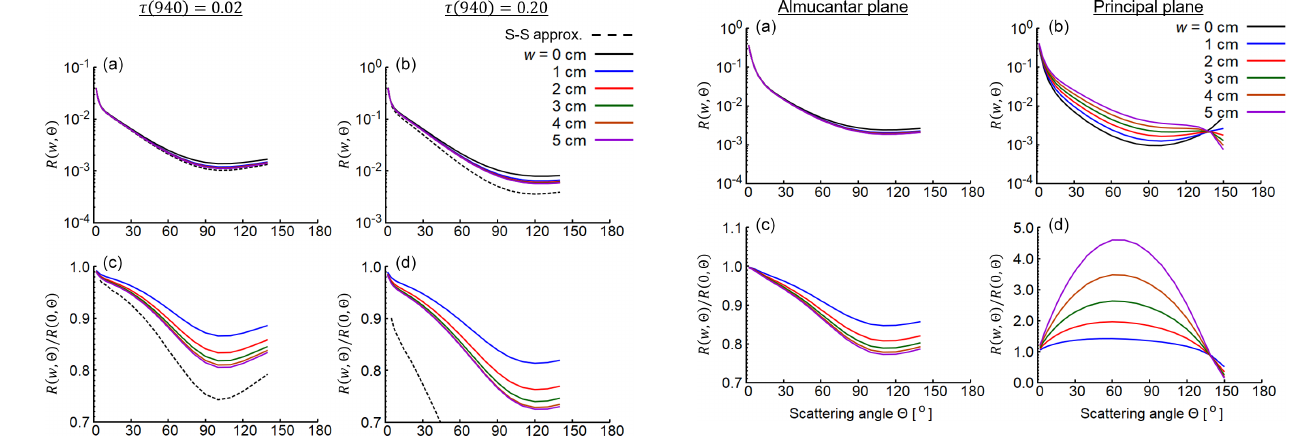
Figure 4. Normalized angular distributions simulated for transported-dust aerosol (Table 2) in the almucantar and prin- cipal planes with an aerosol optical thickness of 0.06 at 940nm. Simulations were conducted for SZA = 70 ◦ and PWV (w) = 0, 1, 2, 3, 4, and 5cm. The top row is the normalized radiance R(w,(cid:50)) , and the bottom row is the ratio of R(w,(cid:50)) to R( 0 ,(cid:50)) . R on PWV is also found in the principal plane. R